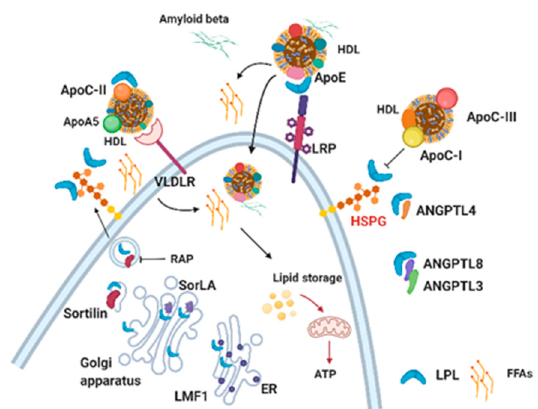
Figure 2. Schematic representation of LPL processing and function. LPL is chaperoned through the ER by LMF1, and sorted through the Golgi apparatus by SorLA / Sortilin. RAP can inhibit Sortilin binding, which may prevent premature secretion and a ffi liation with lipoprotein receptors (e.g., VLDLR and LRP). Secreted LPL is tethered to the cell surface to HSPG, where is may form a complex with lipoprotein receptors. In the brain, it is unknown whether LPL can hydrolyze the lipid components of lipoproteins, and if the canonical activators (i.e., ApoC-II and ApoA5) are involved. LPL may facilitate the endocytosis of lipoproteins via an interaction with cell surface lipoprotein receptors, providing lipids to the cell for storage, membrane formation or energy utilization. LPL also facilitates the endocytosis of A β , which may be HDL bound. ApoC-I and ApoC-III inhibit LPL activity. ANGPLT4 binds to the active site of LPL to inhibit hydrolytic activity. This schematic is largely based on our understanding of LPL function in microglia, and LPL processing may vary in other cells types.